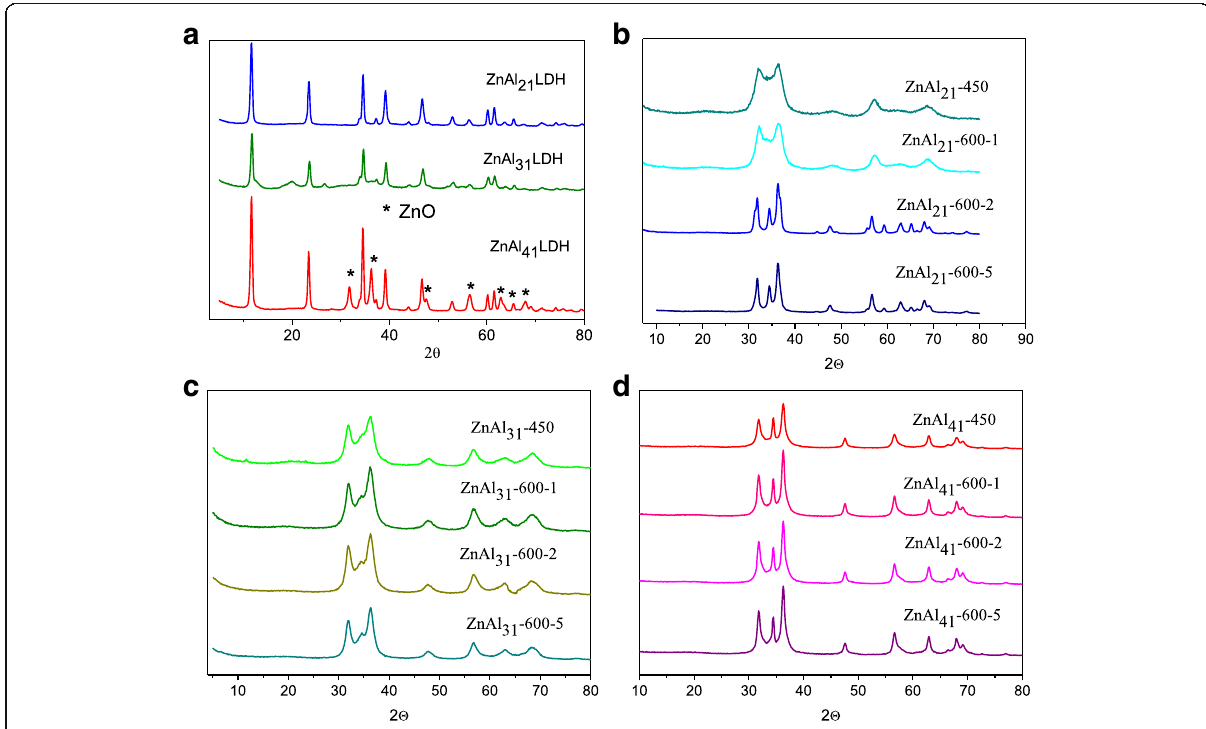
Fig. 1 X-ray diffraction patterns of as-synthesized Zn-Al LDHs ( a ) and calcined: ZnAl 21 LDH ( b ), ZnAl 31 LDH ( c ), ZnAl 41 LDH ( d